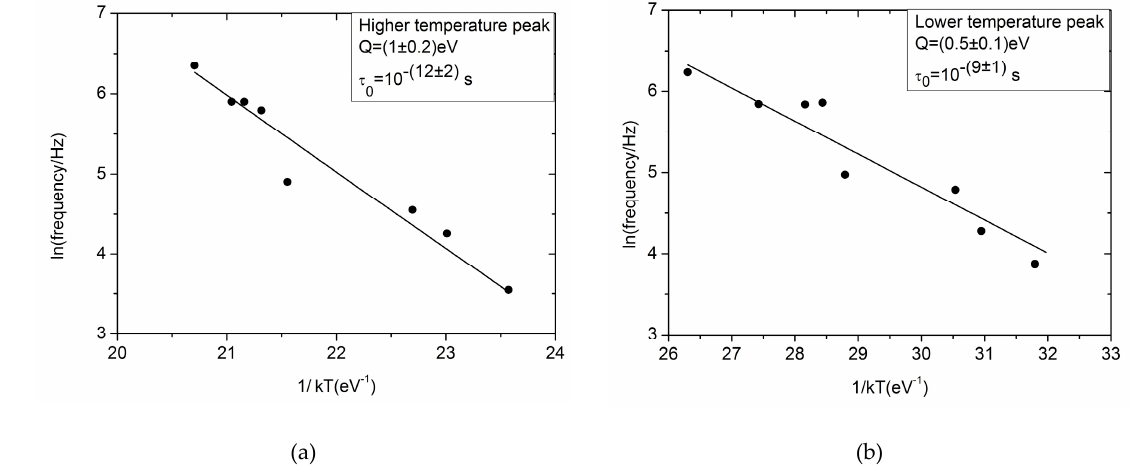
Figure 7. Aluminum specimens of 10 µm thickness. Arrhenius plots are shown for the peaks at higher temperature ( a ) and at lower temperature ( b ).